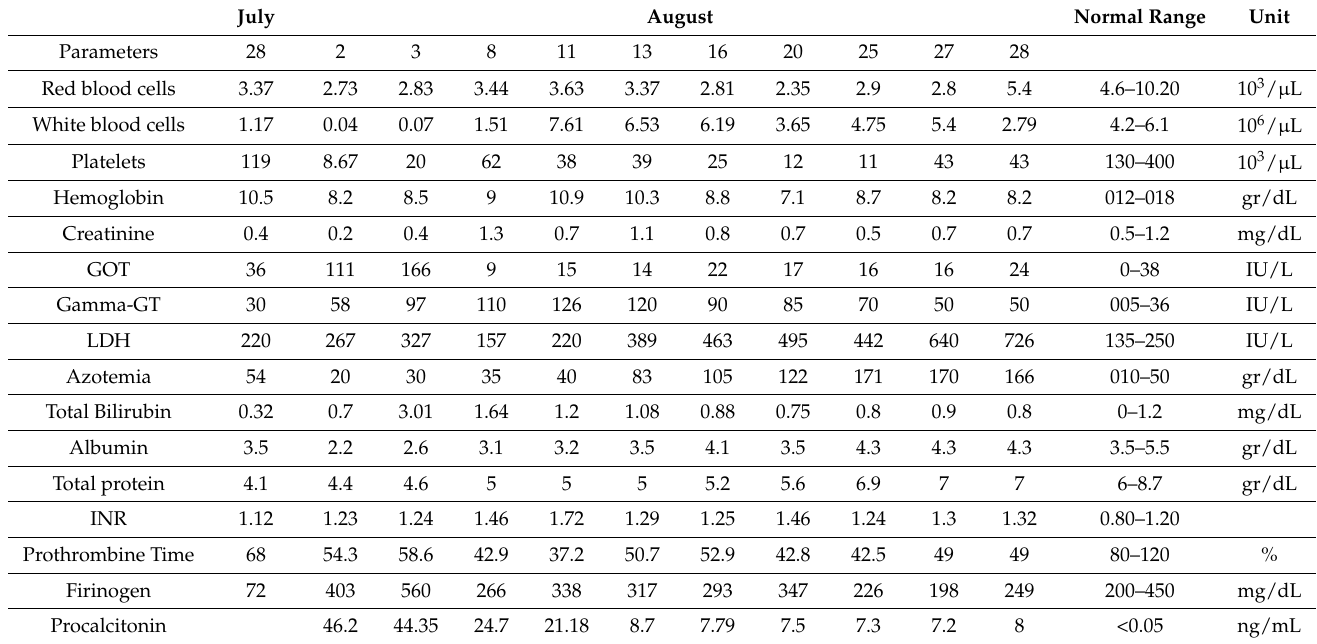
Table 2. Time course of biochemical parameters. GOT: glutamic oxaloacetic transaminase; gamma-GT: gamma-glutamyl transpeptidase; INR: international normalized ratio; LDH: lactate